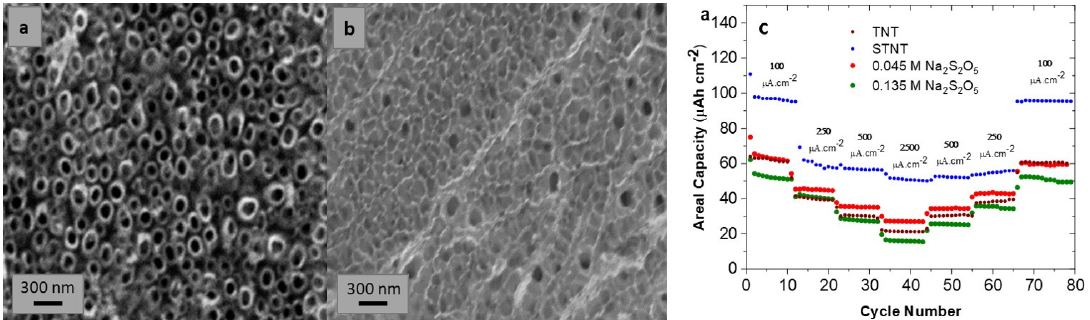
Figure 7. SEM images of the top-view of the samples prepared by anodic oxidation with ( a ) 0.045 M Na 2 S 2 O 5 ; ( b ) 0.135 M Na 2 S 2 O 5 , along with ( c ) rate capability data of the prepared electrodes in comparison to TNT and STNT